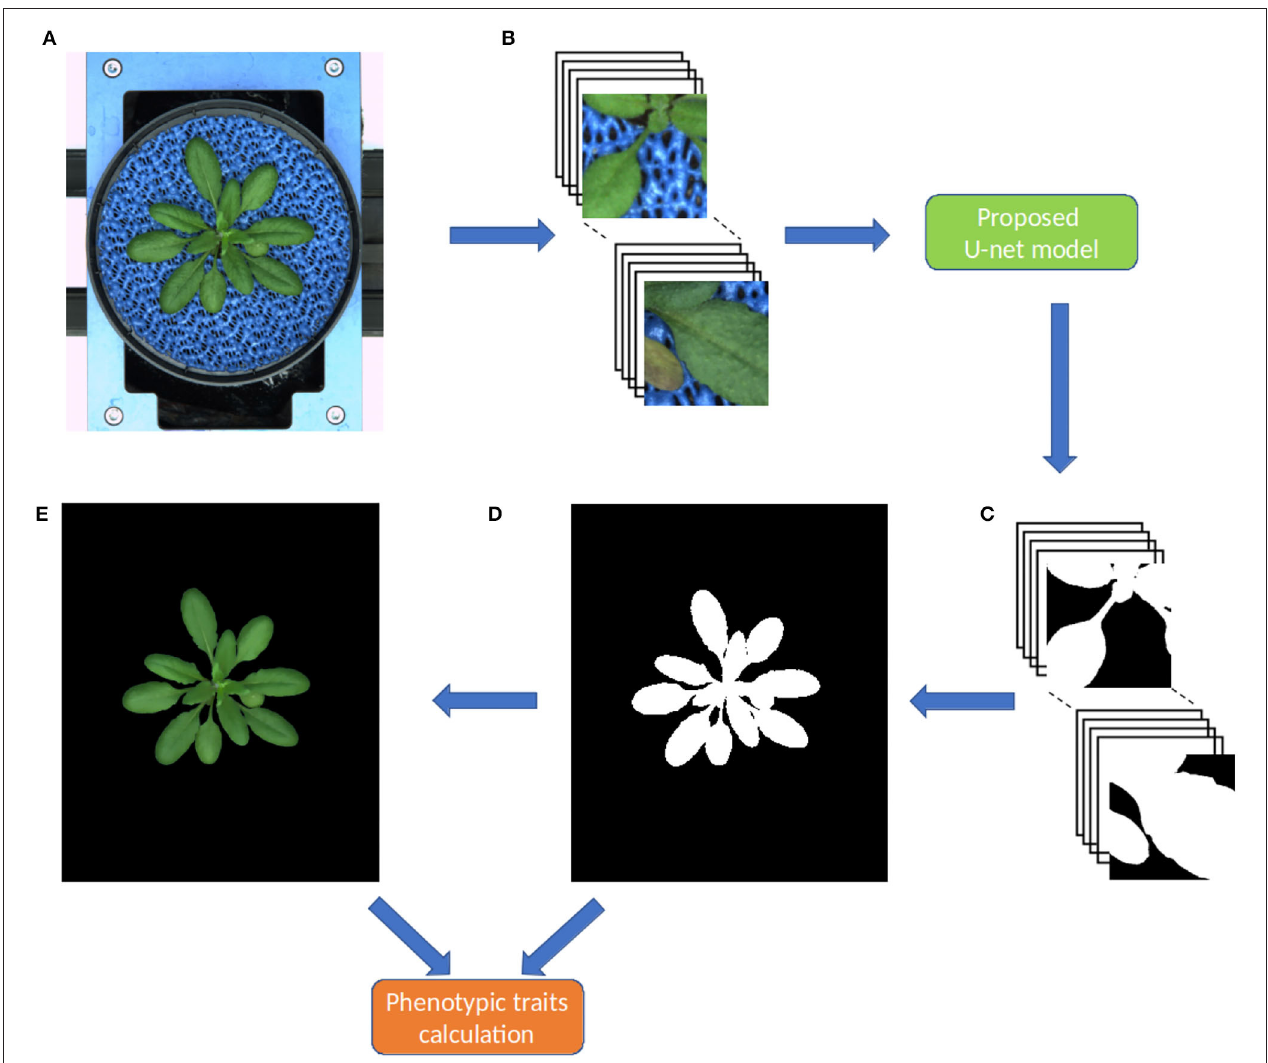
FIGURE 3 | Workflow of the pipeline for image processing and segmentation in the DeepShoot tool. Green and orange color boxes represent the operations of image segmentation and trait calculation: (A) original image, (B) original image patches of size 256 x 256, (C) segmented image patches of size 256 x 256, (D) binary segmentation of the original image, (E) RGB color space of (D)